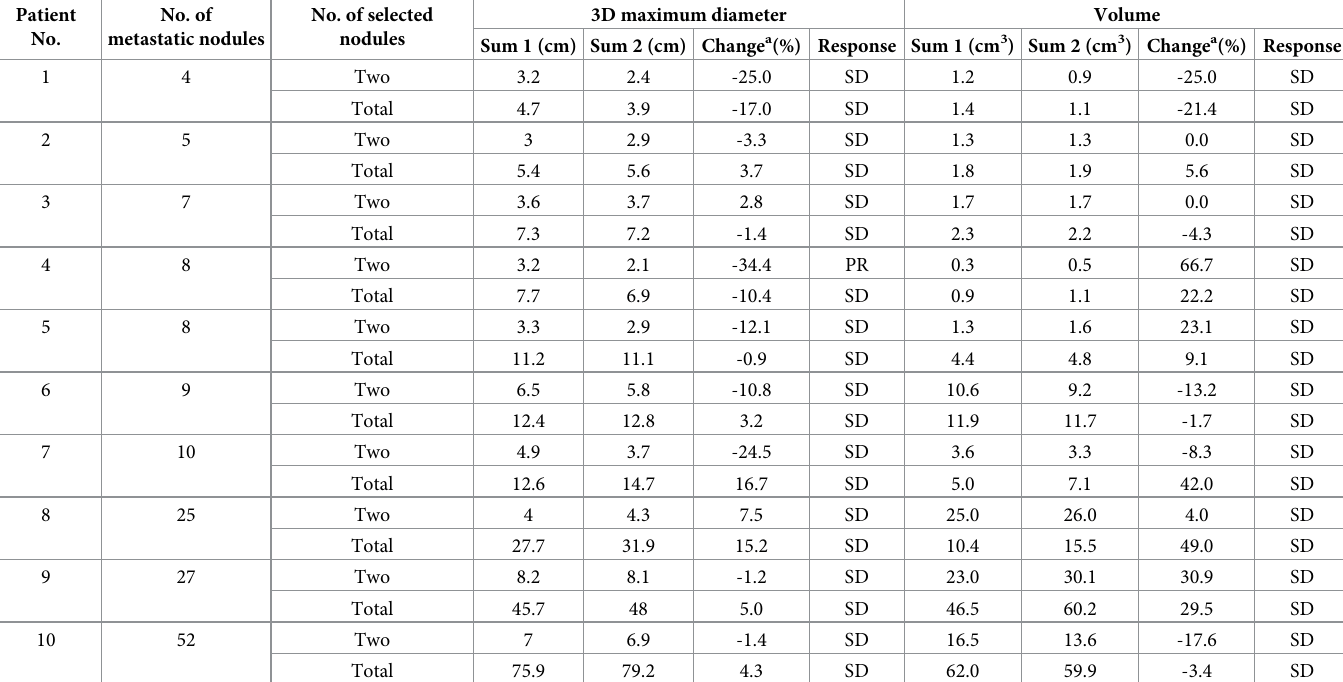
Table 2. Tumor response assessment based on the number of metastatic nodules measured by semi-automated 3D CT volumetry. Patient No. of No. metastatic